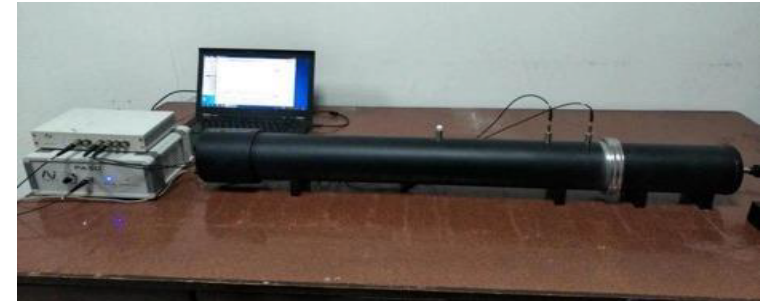
Figure 4: Impedance tube for the test of sound absorption coefficients.